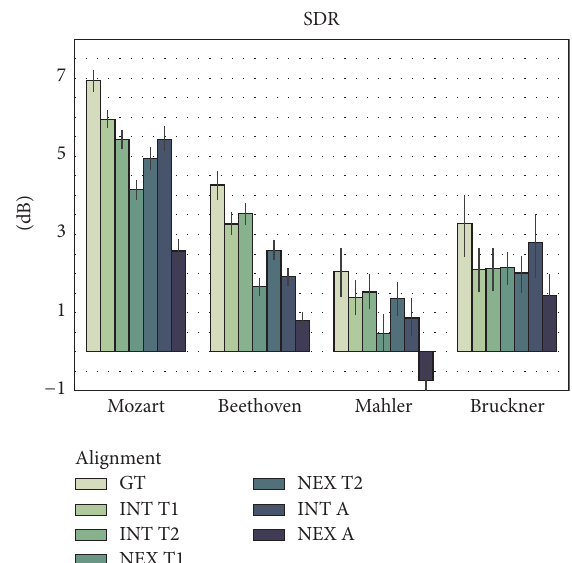
Figure 9: Results in terms of SDR, SIR, SAR, and ISR for the combination between different offset estimation methods (INT and Ext) and different sizes for the tolerance window for note onsets and offsets (T1 and T2). GT is the ground truth alignment and Ali is the output of the score